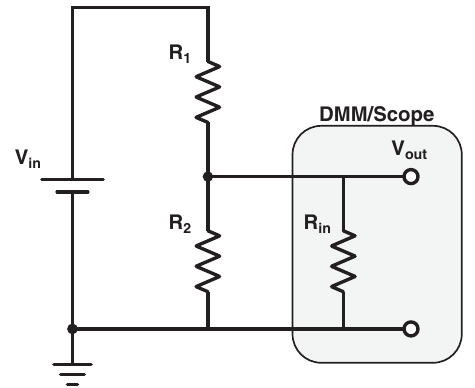
FIG. 2. Voltage divider circuit for Activity 1 (a version of this, without the measurement device shown, was included in the students ’ prelab). Resistors R 1 and R 2 were both either 1 or 10 M Ω , depending on the version of the circuit being tested. The measurement device is depicted with the input resistance labeled R . Everything in the box is internal to the measurement in